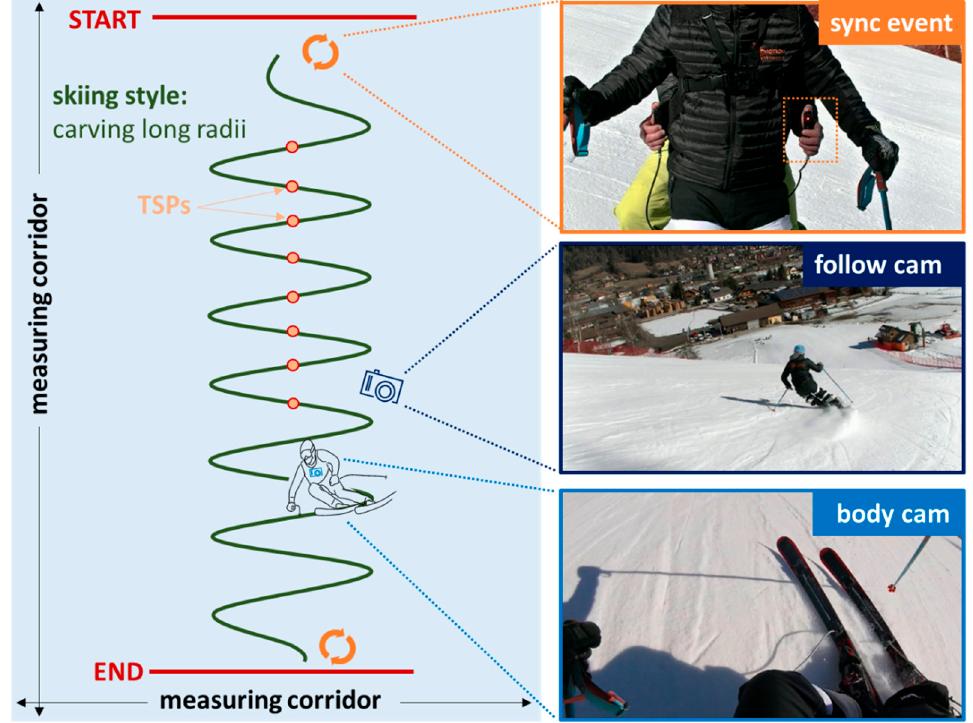
Figure 4. Experimental field setup. TSPs: Turn switch points.